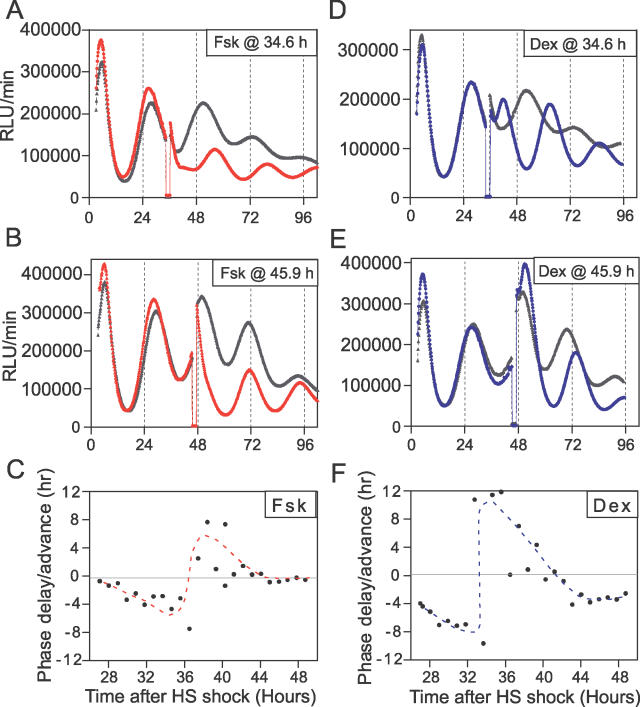
PRCs for Fsk versus Dex in Rat-1 CellsConfluent Rat-1/Pmper2::dLuc cells were shocked with 50% horse serum at time 0. At the indicated circadian times during the second cycle (Day 2), cultures were treated for 2 h with either 10 μM Fsk (red line) in parallel with its solvent control (0.1% DMSO, gray line) or with 100 nM Dex (blue line) in parallel with its solvent control (0.001% EtOH, gray line). A representative trace for treatment and control is shown in panels (A), (B), (D), and (E). PRCs are plotted as phase shifts on the ordinate (delay shifts plotted as negative values, advance shifts as positive values) versus time after the horse serum (HS) treatment on the abscissa.(A) Pulse (2 h) of 10 μM Fsk or of 0.1% DMSO control at hour 34.6.(B) Pulse (2 h) of 10 μM Fsk or of 0.1% DMSO control at hour 45.9.(C) PRC for 10 μM Fsk pulses. Phases were corrected for the shifts by 0.1% DMSO.(D) Pulse (2 h) of 100 nM Dex or of 0.001% EtOH control at hour 34.6.(E) Pulse (2 h) of 100 nM Dex or of 0.001% EtOH control at hour 45.9.(F) PRC for 100 nM Dex pulses. Phases were corrected for the shifts by 0.001% EtOH.